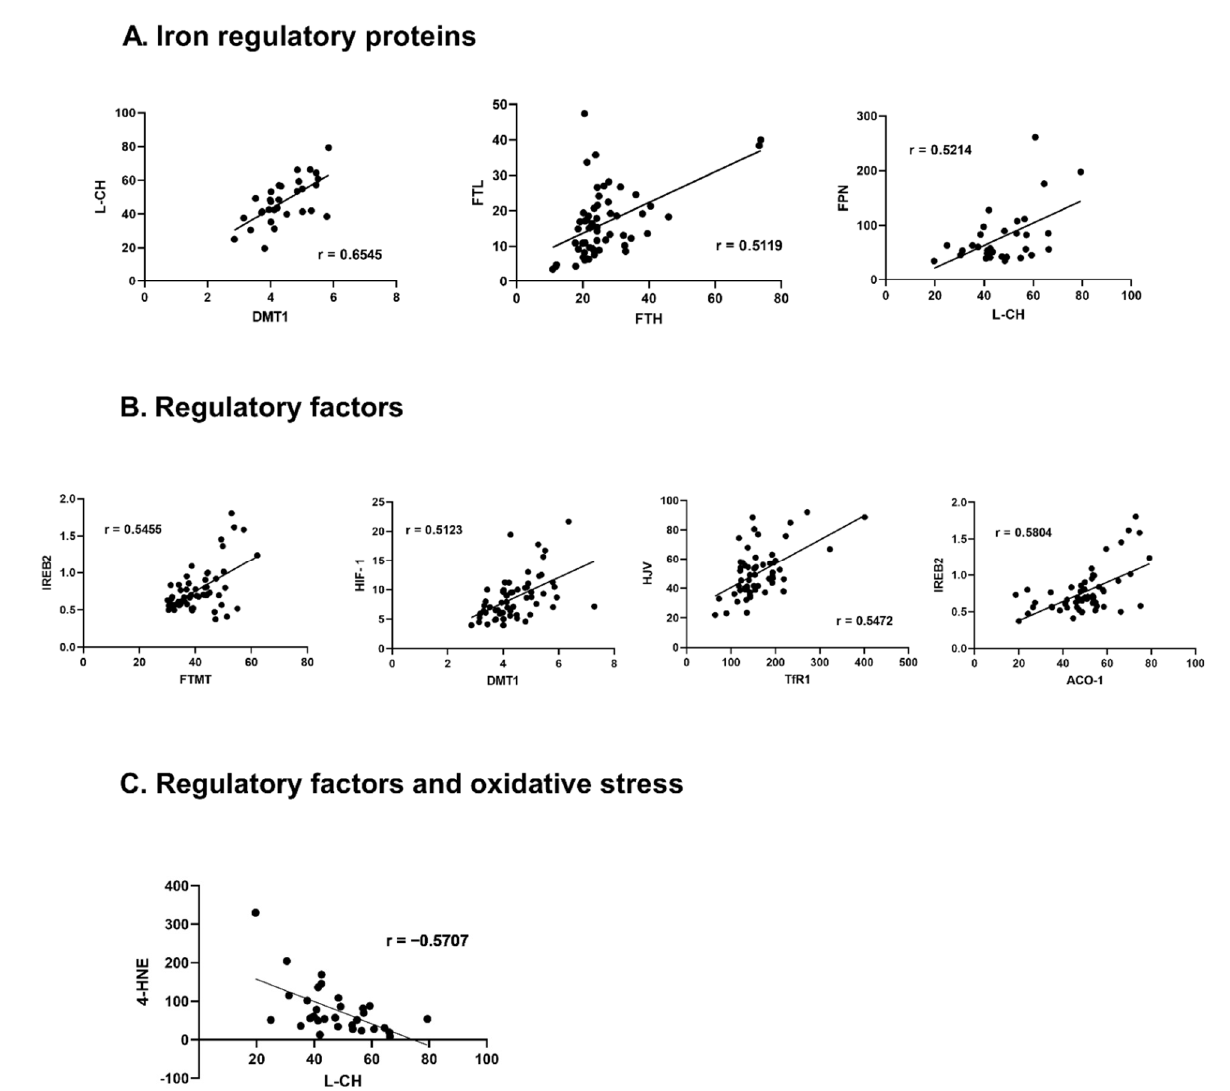
Figure 3. Correlations between iron handling proteins, their regulatory factors, and an oxidative stress marker in the failing human myocardium. ( A )—Iron regulatory proteins, ( B )—regulatory factors, ( C )—Regulatory factors and oxidative stress. Only significant, highly-correlated proteins (r > 0.5, p < 0.05) are shown, all correlations are presented in the supplement (Table S7); r—Pearson correlation coefficient. Aberrations: HF (failing hearts), NHF (non-failing hearts), DMT-1 (divalent metal transporter -1), L-CH (L-type calcium channel Subunit CACNa1D), TfR-1 (transferrin receptor -1), FT-H (ferritin heavy chain), FT-L (ferritin light chain), FT-MT (ferritin- mitochondrial), FPN (ferroportin), ACO-1 (aconitase- 1), IREB-2 (iron response protein-2), HIF-1 (hypoxia-induced